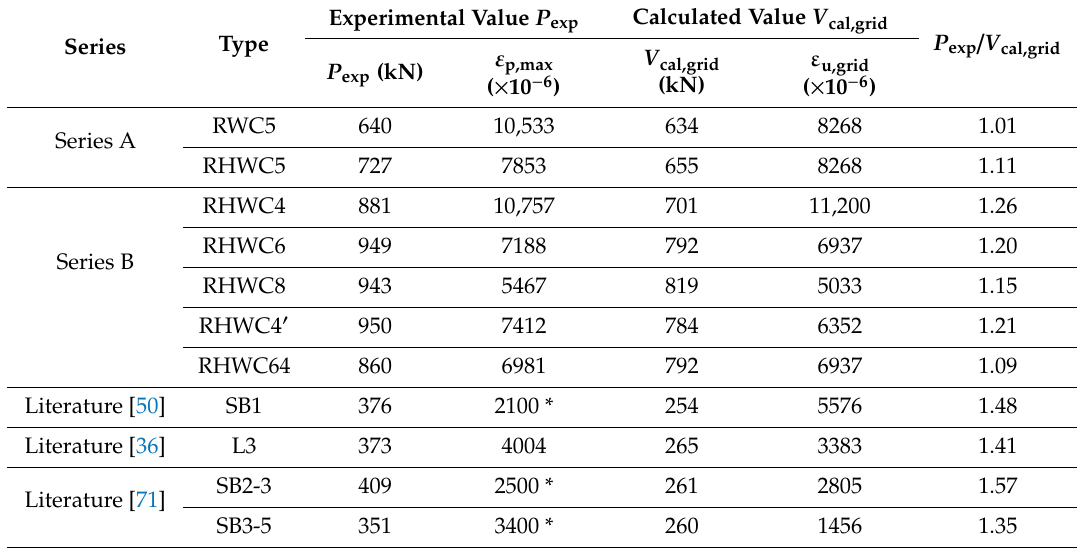
Table A1. Comparison between calculated value V cal,grid and the corresponding experimental